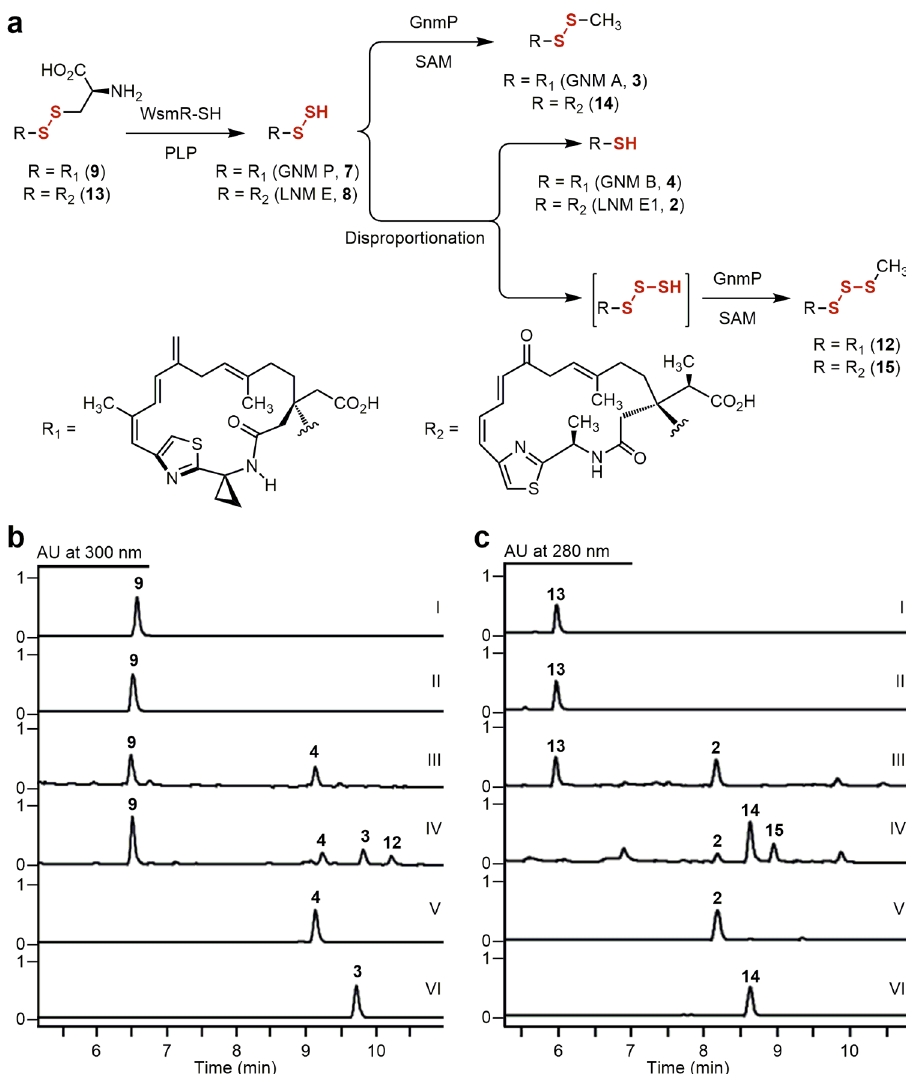
Fig. 3 Disproportionation of GNM P (7) and LNM E (8) to GNM B (4) and LNM E1 (2), and their corresponding hydrotrisul fi des, revealing 4 and 2 as shunt metabolites in GNM and LNM biosynthesis. a Disproportionation reaction of 7 or 8 , generated in situ using 9 or 13 as a surrogate substrate, to 4 or 2 and the corresponding hydrotrisul fi des, which can be trapped by GnmP in situ to afford the S -methylated trisul fi de 12 or 15 , respectively. b HPLC analysis of 7 disproportionation: (I) substrate 9 , (II) 9 + WsmR-SH (boiled), (III) 9 + WsmR-SH, (IV) 9 + WsmR-SH + GnmP + SAM, (V) standard 4 , and (VI) standard 3 . Substrate and enzyme concentrations used: 9 , 1 mM; SAM, 2 mM; WsmR-SH, 220 μ M; and GnmP, 10 μ M. Incubation time: 3 min for all assays. c HPLC analysis of 8 disproportionation: (I) substrate 13 , (II) 13 + WsmR-SH (boiled), (III) 13 + WsmR-SH, (IV) 13 + WsmR-SH + GnmP + SAM, (V) standard 2 , and (VI) standard 14 . Substrate and enzyme concentrations used: 13 , 5 mM, SAM, 10 mM; WsmR-SH, 220 μ M; and GnmP, 10 μ M. Incubation time: 3 min for assays II and III and 2 h for assay IV,